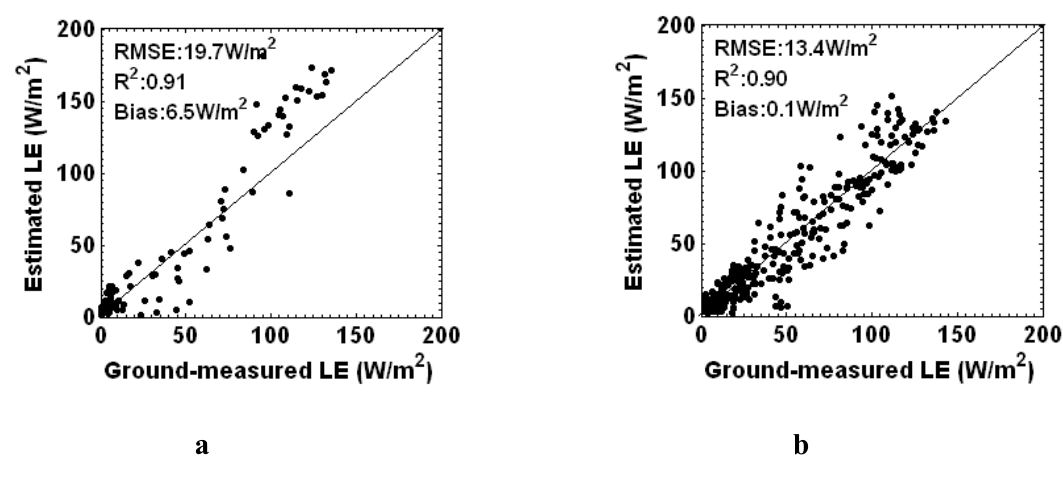
Figure 2. Independent validation of the estimated daily evapotranspiration (ET) using